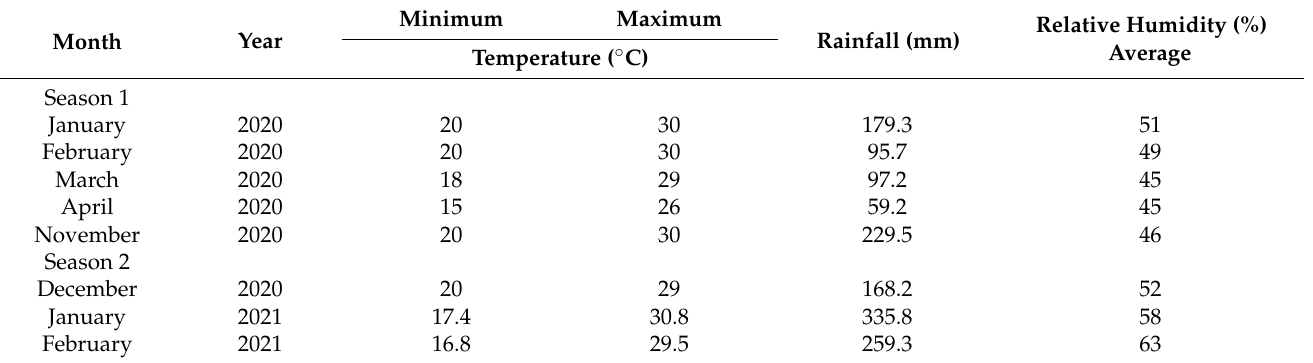
Table 6. Weather conditions at NWU Mafikeng garden.